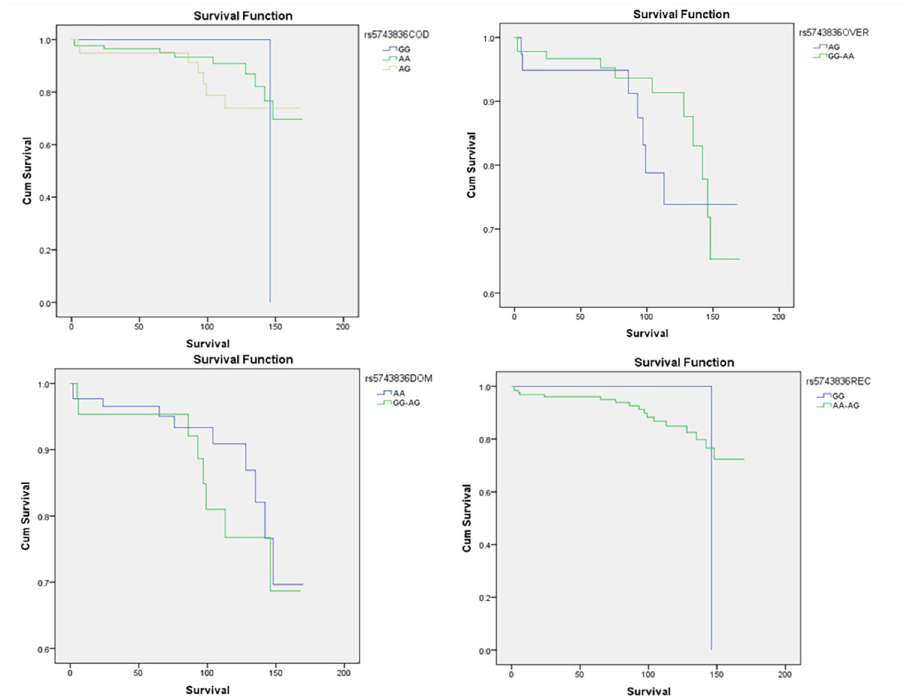
Fig 1. Overall survival (OS) for 130 HL patients according to SNP rs5743836 in different genetic models. Top row from left to right: (a) Comparison among CC, TT, and CC in the codominant model (p-value = 0.58). (b) Comparison among TC and CC/TT in the overdominant model (p-value = 0.42). Bottom row from left to right: (a) Comparison among TT and CC/TC in the dominant model (p-value = 0.66). (b) Comparison among CC and TT/TC in the recessive model (p-value = 0.32). All p-values indicated were Wilcoxon (Gehan)